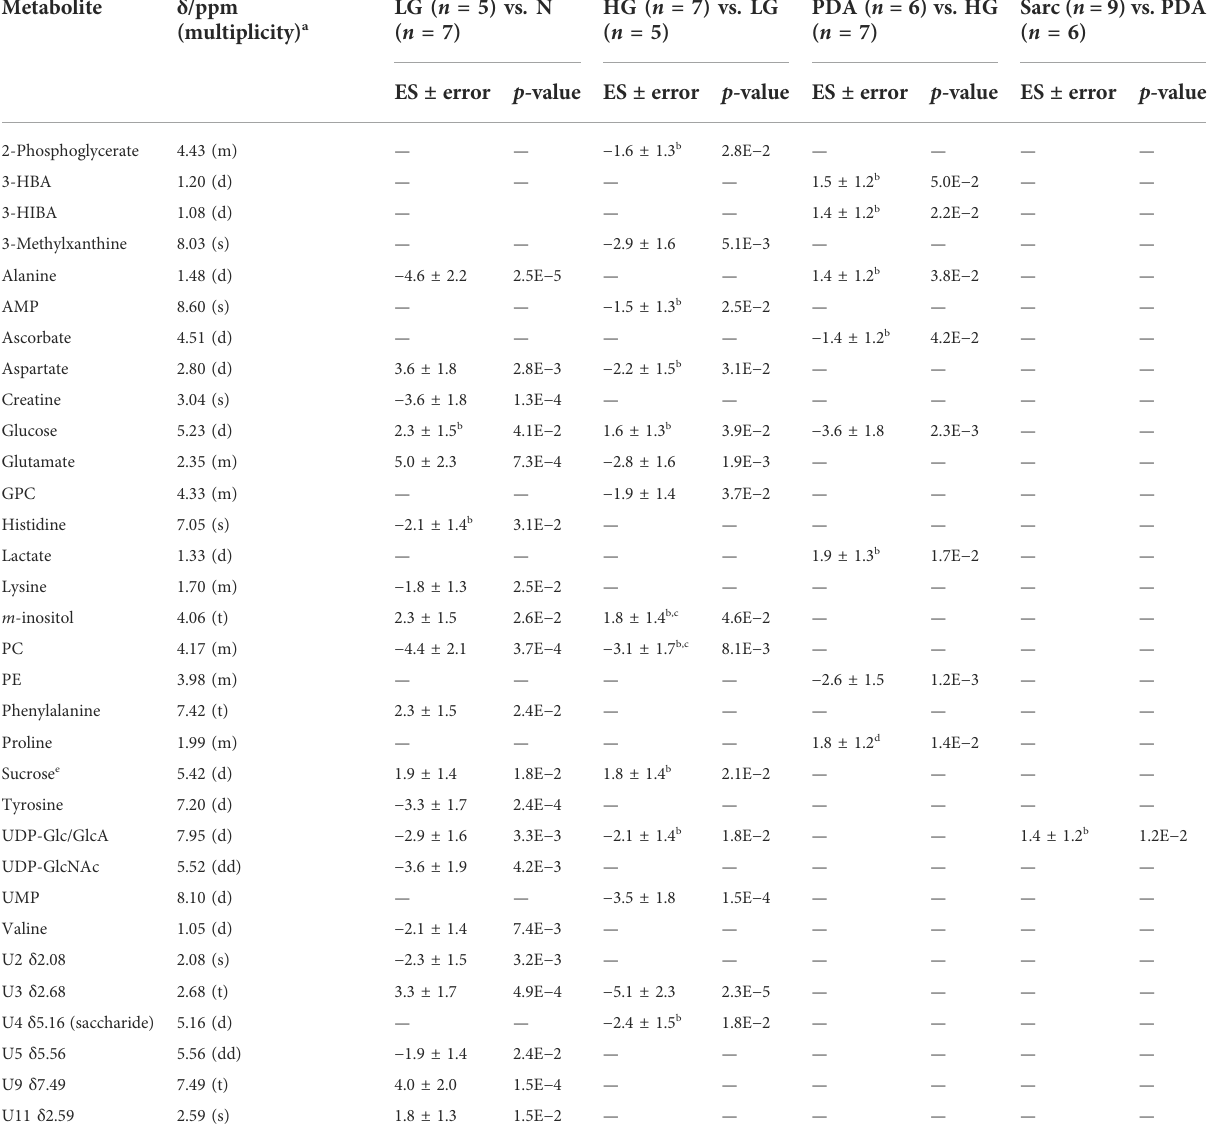
TABLE 3 Polar pancreatic metabolites varying across progression from normal pancreatic tissue (N), through LG PanIN lesions, HG PanIN lesions, to PDA and sarcomatoid carcinoma (Sarc). Metabolite